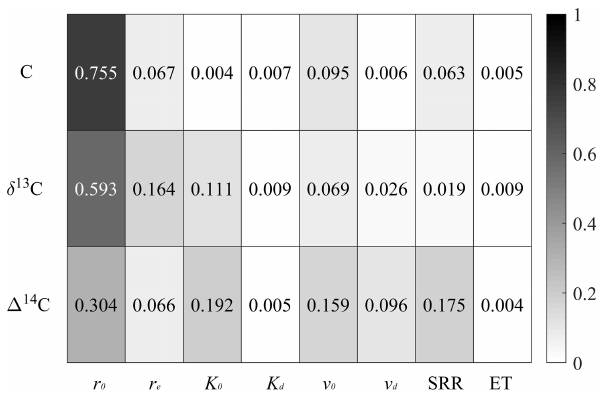
Figure 7. The matrix of the proportion of variance of the differ- ence between reference profiles and Monte Carlo scenario profiles caused by model parameters as indicated by the FAST coefficients. SRR indicates the soil redistribution rate, and ET indicates erosion